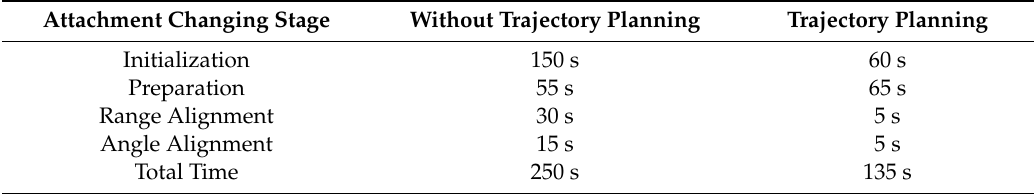
Time consumption of attachment changing with trajectory planning and without trajectory